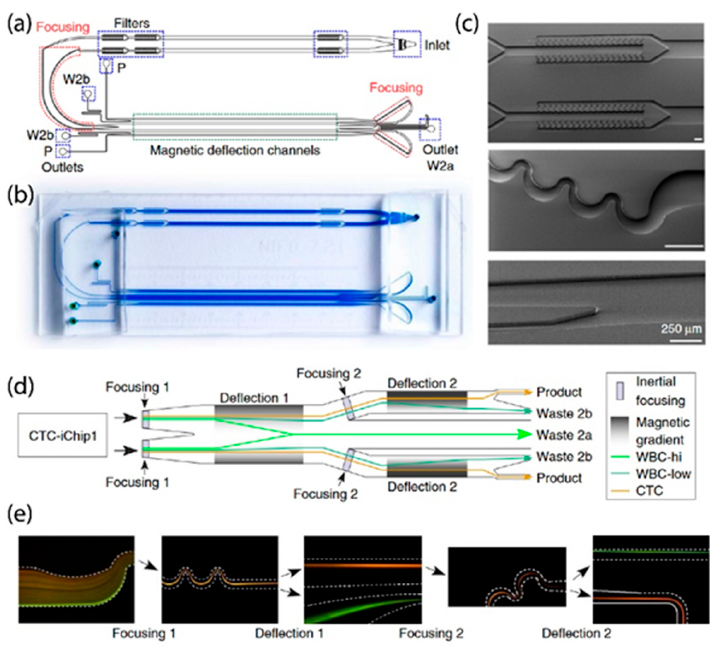
Figure 9. Design of the magnetophoretic module for CTC enrichment. ( a ) CAD design ( b ) Image of the microfluidic chip ( c ) Electron microscopy images showing the microfluidic filtration (top), inertial focusing (middle) and deflection channels (bottom). ( d ) Simplified operation of the magnetophoretic chip. ( e ) Fluorescent imaging of the microfluidic features while the device is in operation. Reproduced with permission [78]. Copyright 2014 Nature Publishing Group.